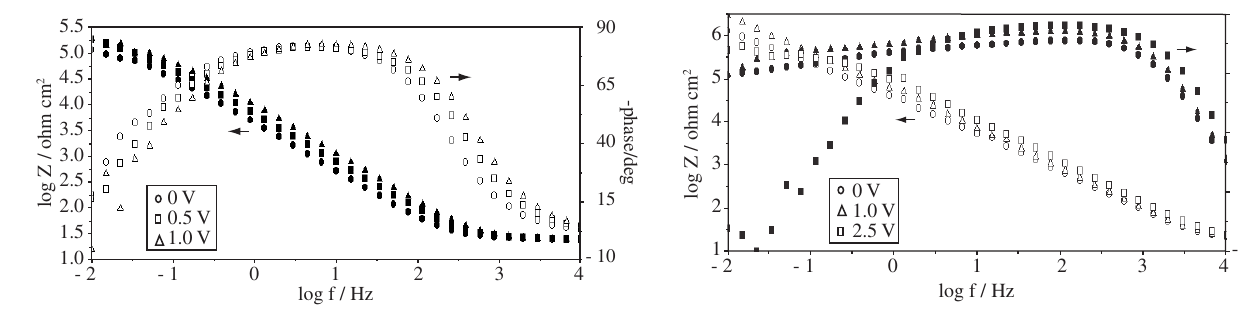
Figure 8. Bode plots of Ti6Al4V obtained in citric acid after anodic polariza- tion at 0 ( ● ), 0.5 ( ■ ) and 1.0 ( ▲ ) V.